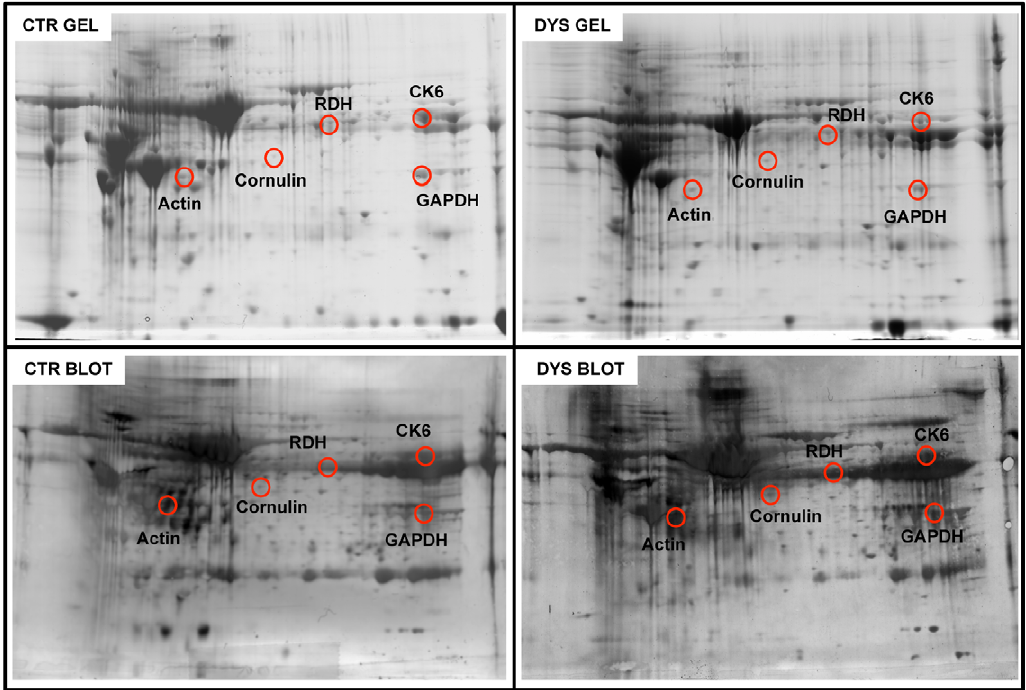
Figure 4. Oxidized protein detection by redox proteomics (DYS vs. CTR). Top: 2D maps of CTR (left) and DYS (right) cervical tissues. Proteins (300 m g) were separated in first dimension (pH 3–10 linear IPG); second dimension was performed on slab gel (12% gradient SDS-PAGE). Protein detection was achieved using Biosafe Coomassie staining. Bottom: 2D carbonyl immunoblots of CTR (left) and DYS (right) cervical tissues. The spots showing significant increased carbonyl levels are labeled. Relative change in carbonyl immune-reactivity, after normalization of the immunostaining intensities to the protein content, was significant for five spots. The identified proteins are listed in table III.